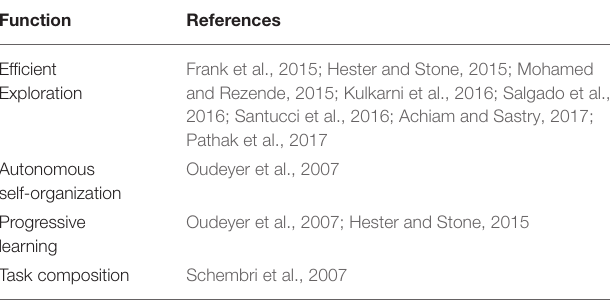
TABLE 4 | List of functions resulted from computational models of intrinsic motivation.